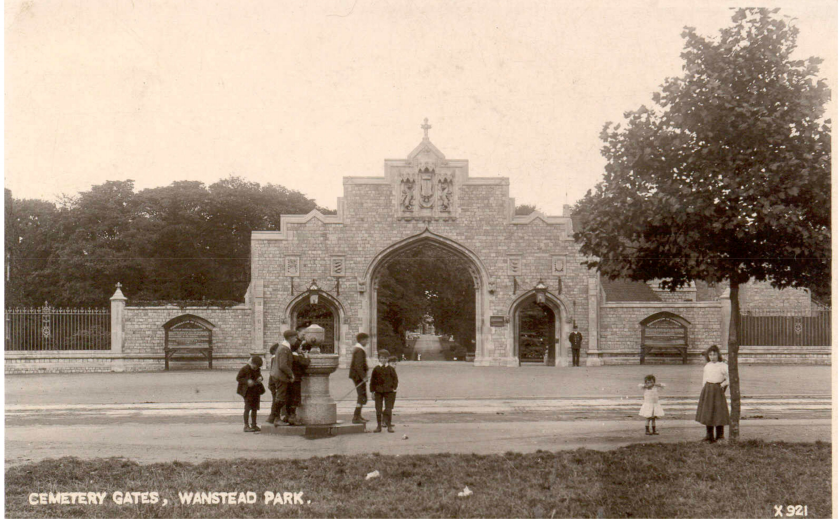
Figure 2. Robertson 2. The entrance to the City of London Cemetery. Robertson was superintendent and registrar from 1913 to